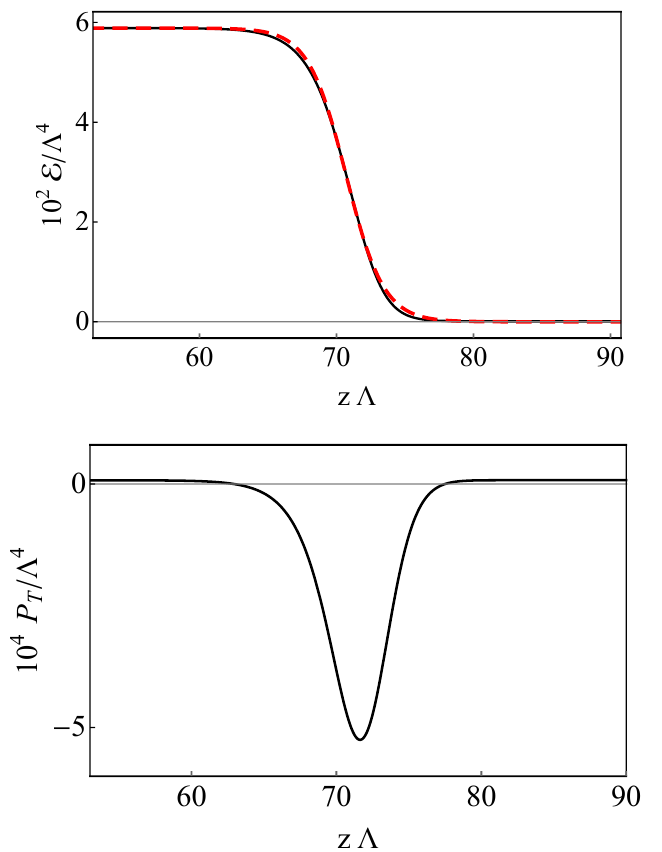
Figure 29 . Energy density (top) and transverse pressure (bottom) in the (cid:12)nal phase-separated solution of (cid:12)gure 4(left). In (top) the continuous black curve is the exact energy density, whereas the dashed red curve shows the analytical approximation